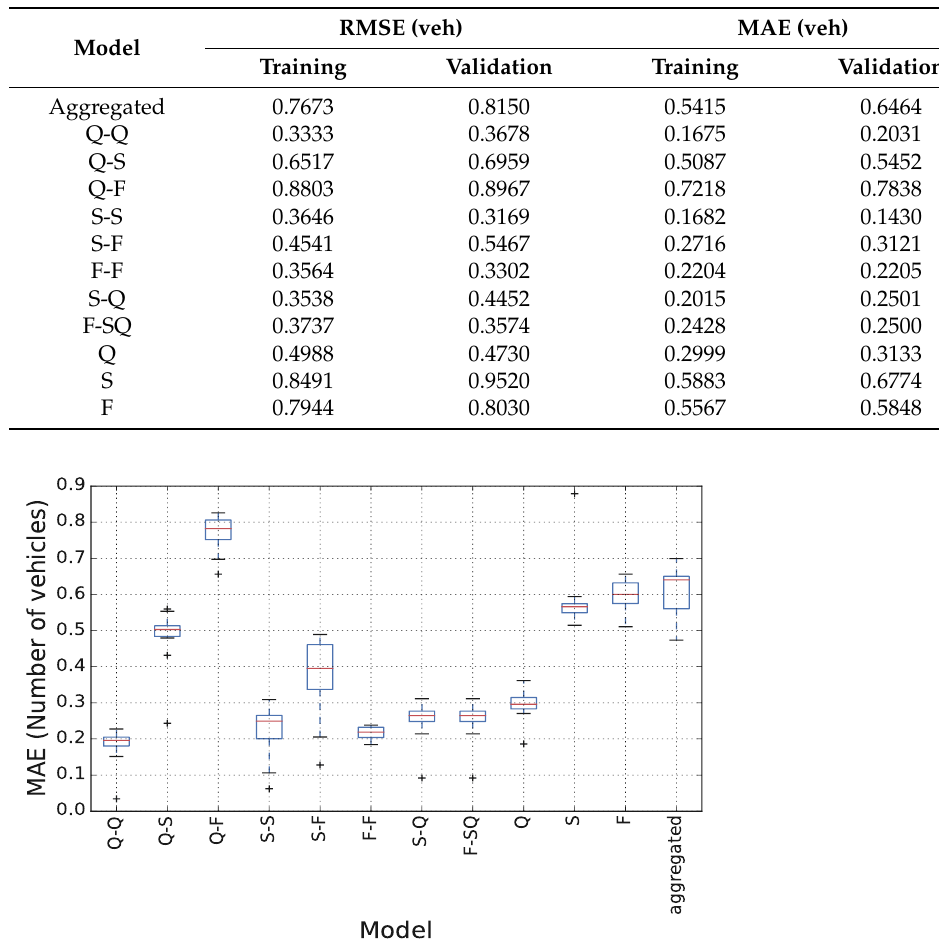
Table 7. Performance measures for the proposed estimation methods.